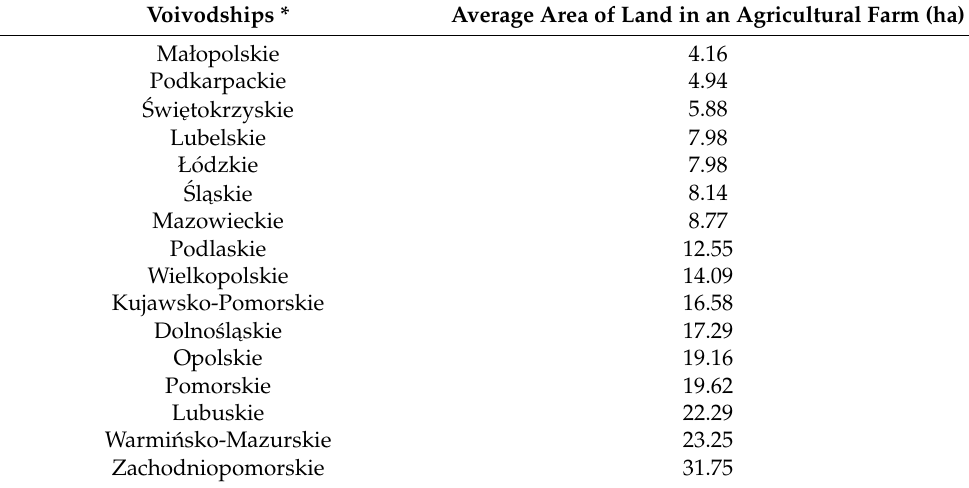
Table 2. Average area of land in an agricultural farm in 2020 in Poland